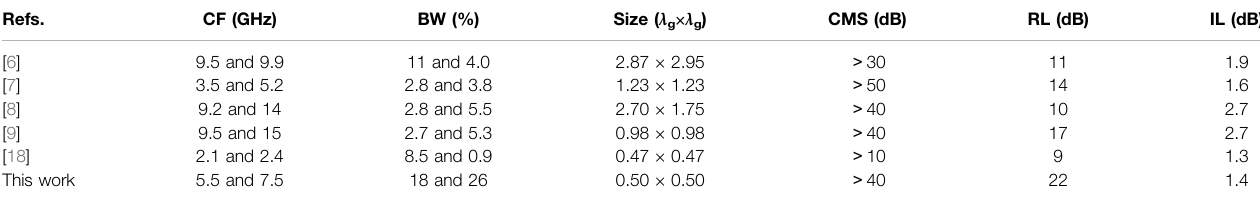
TABLE 1 | Comparison with other previous works.